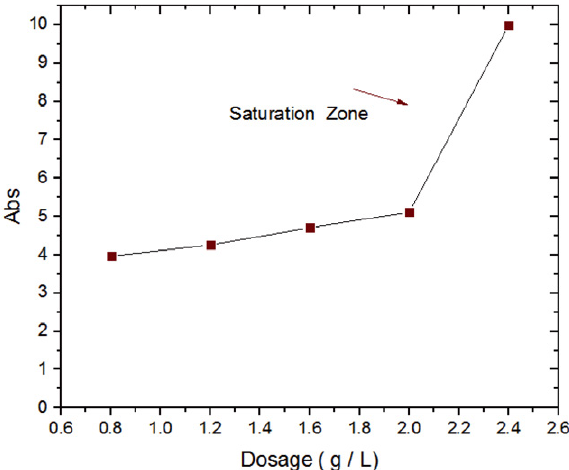
Figure 6. Effect of used dosage of nanocomposite on the DOX ad- sorption